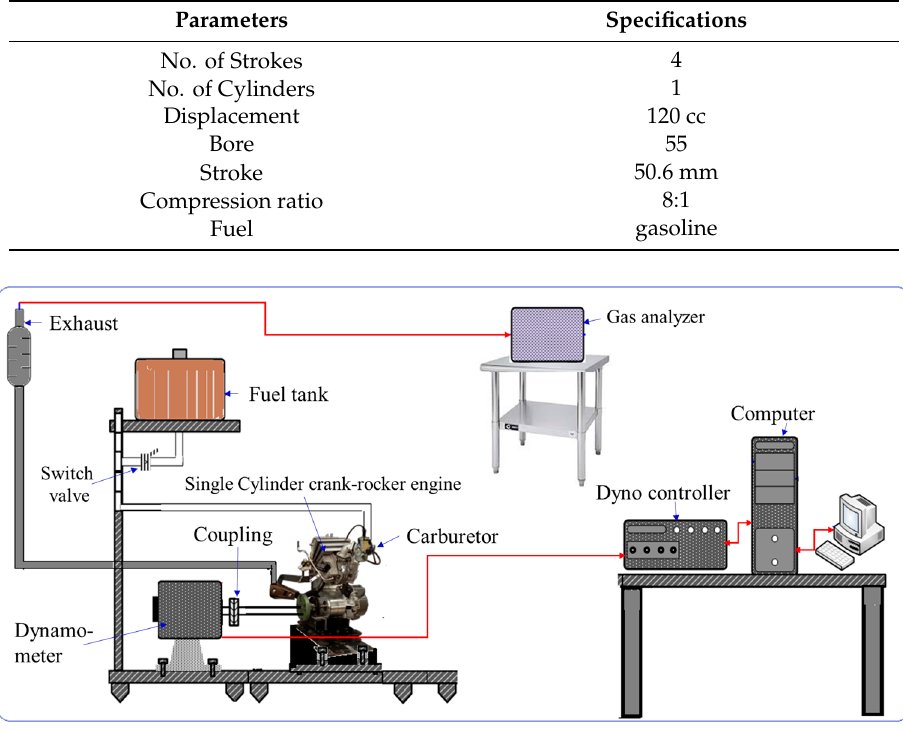
Figure 5. Crank-rocker gasoline engine experimental set-up.